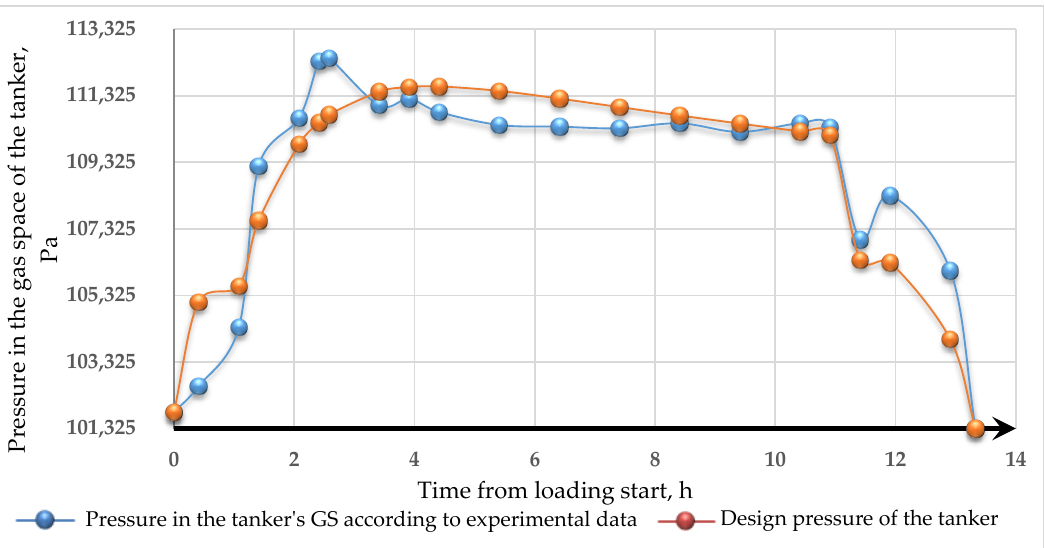
Figure 6. Results of modeling the dynamics of pressure changes in the tanker’s GS and experimental Figure6. data.